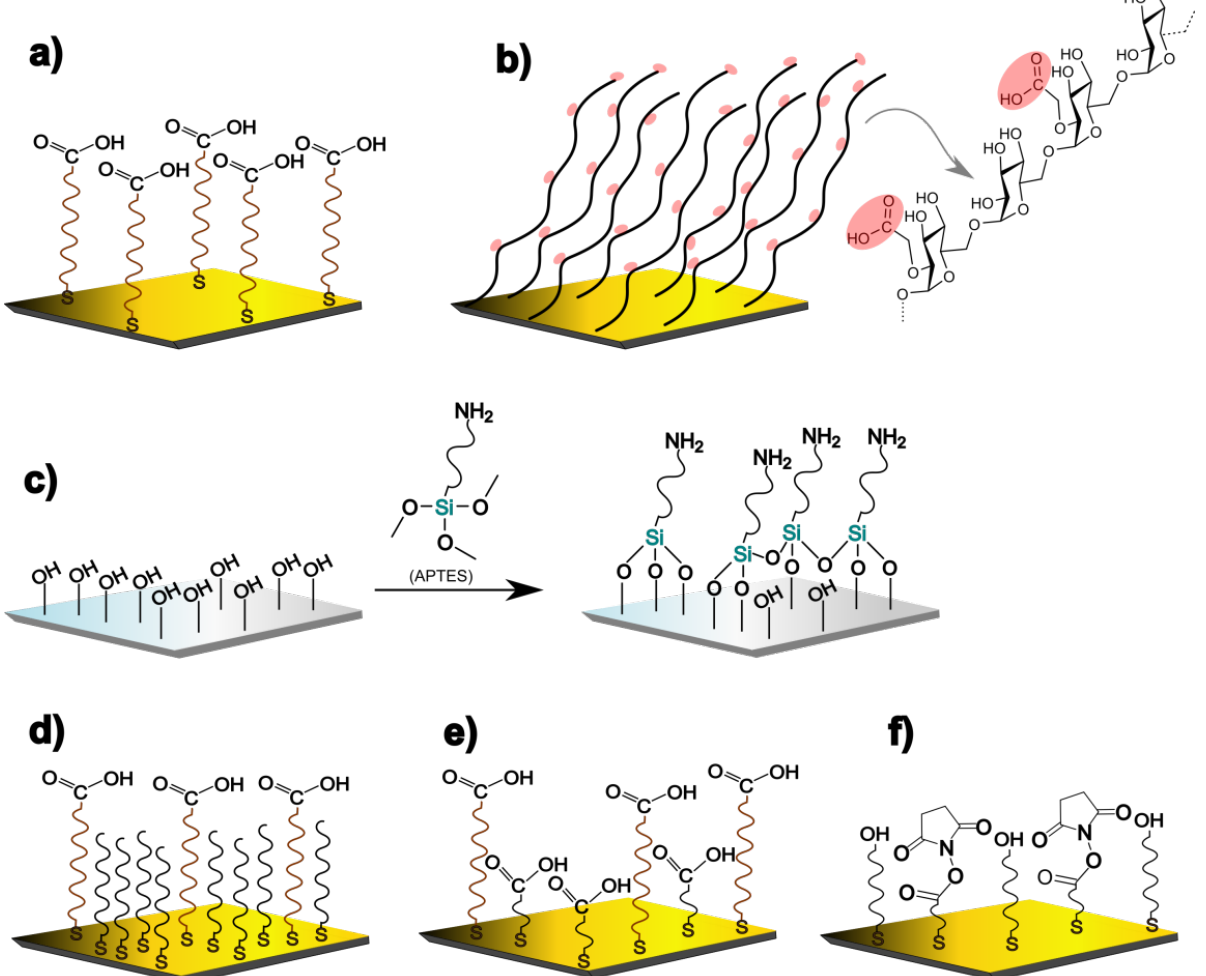
Figure 2. Schematic representation of chemically modified gold surfaces for SPR experiments: ( a ) alkanethiol self-assembled monolayer (11-mercaptoundecanoic acid); ( b ) dextran-modified polymeric layer (carboxymethylated dextran); ( c ) silicon-modified glass-based chip (silanization reaction via APTES); modified thiol surfaces with mixed species for avoiding non-specific interaction; ( d ) 11-MUA/1-octanethiol (adapted from [22] with permission of Elsevier); ( e ) 11-MUA/3-mercaptopropionic acid (adapted from [24]). This is an unofficial adaptation of an article that appeared in an ACS publication. ACS has not endorsed the content of this adaptation or the context of its use; ( f ) DSP/MCH. Adapted from [25] with permission of Wiley.